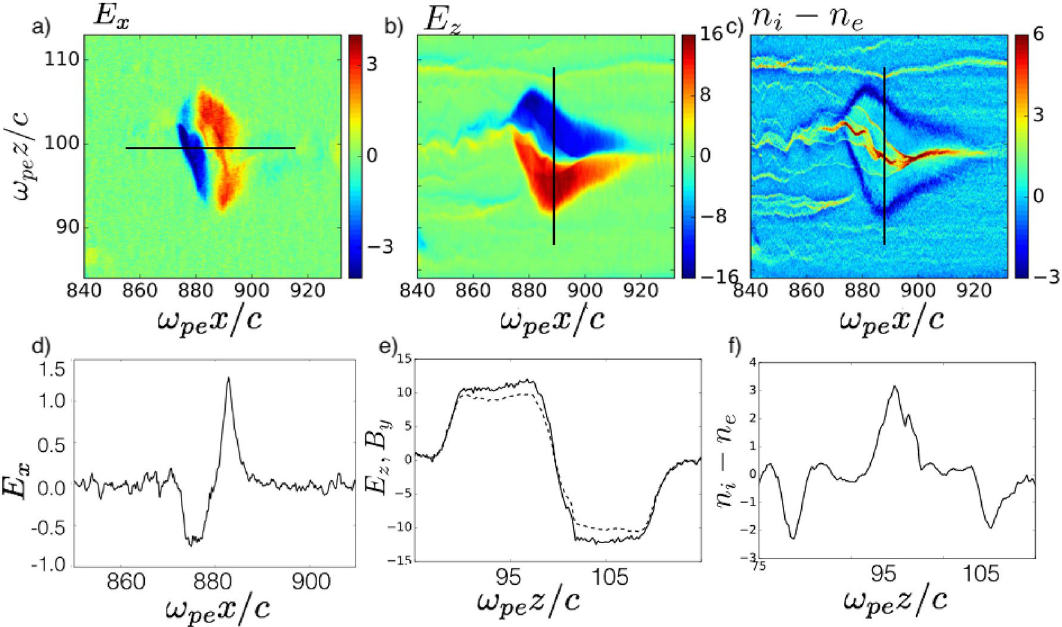
Figure 2. ( a ) Distribution of longitudinal electric field ( E x ) of MV, ( b ) transverse electric field ( E z ) ( c ) charge 1057 . ( d ) lineout of the longitudinal electric field along line shown in ( a ). ( e ) lineouts of the density at ω pe t = transverse electric field (dashed line) and out of plane magnetic field (solid line) corresponding to the line shown in ( b ). ( f ) lineout of charge density along the line shown in ( c